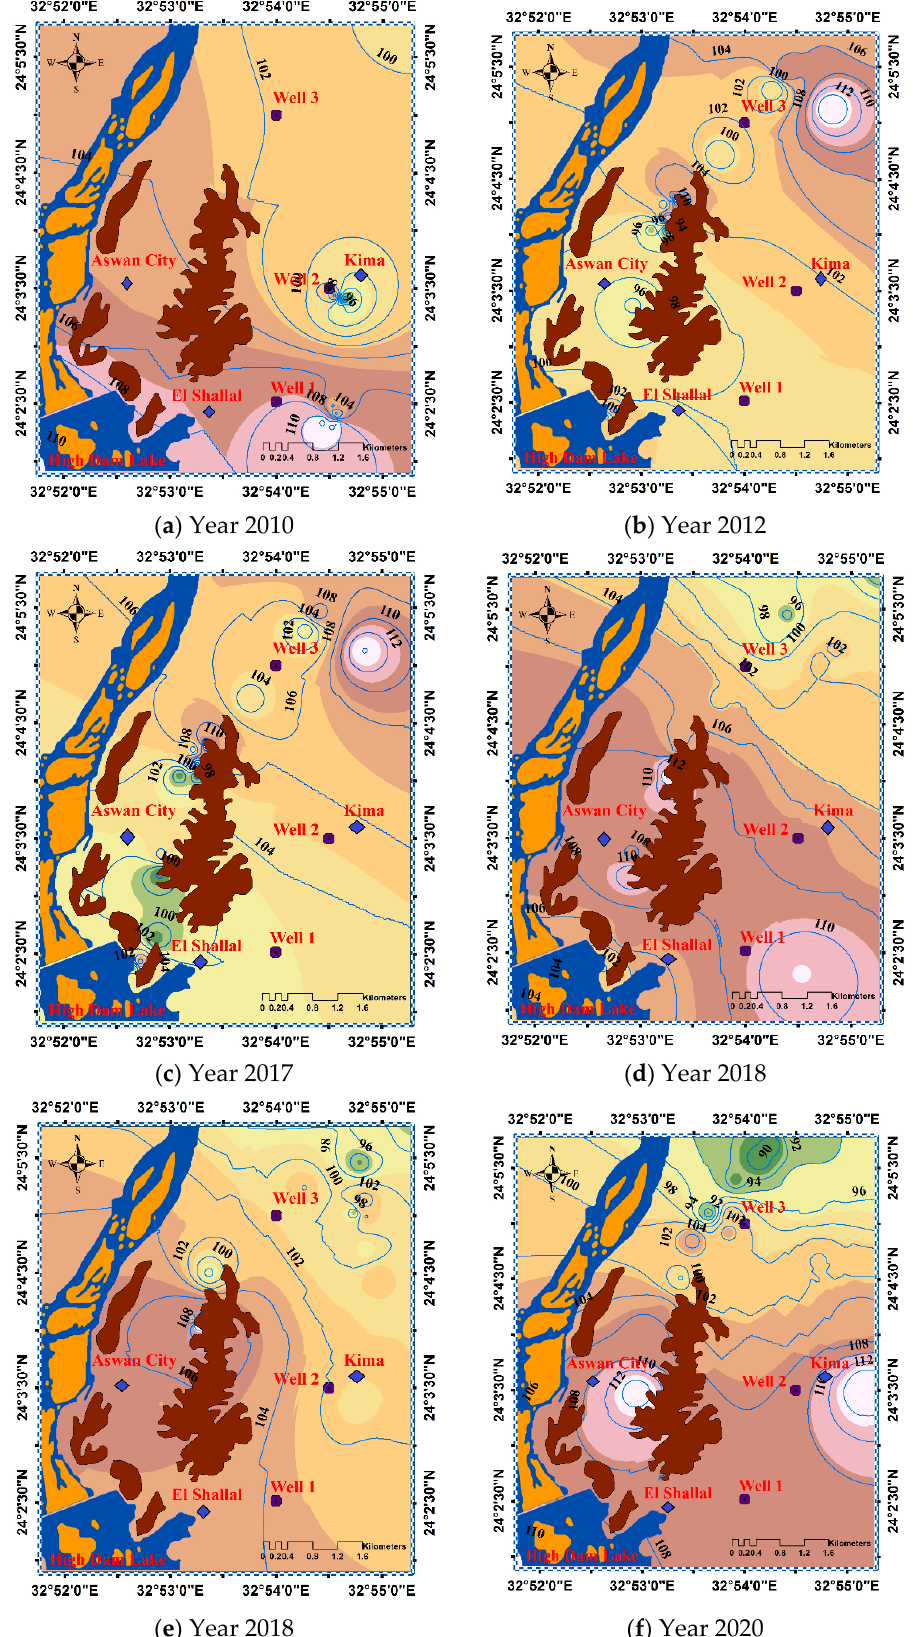
Figure 8. Groundwater distributi o n maps in the study area of Aswan city for different years.